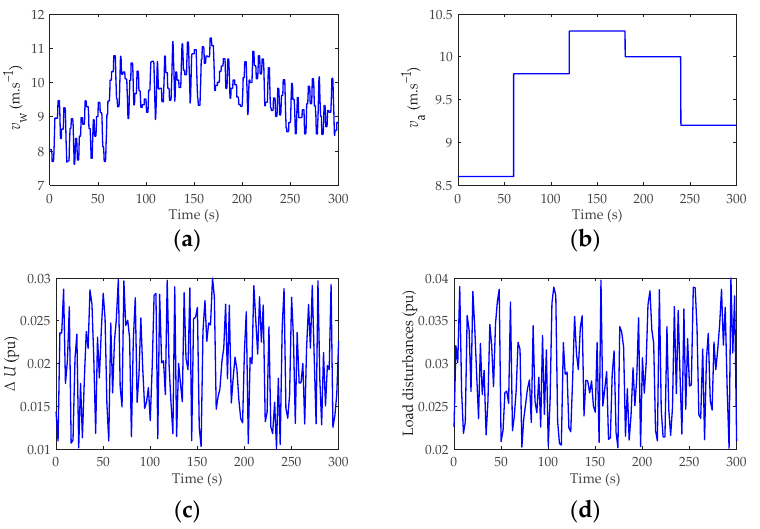
Figure 9. External disturbances and system uncertainties ( a ) Wind speed v w . ( b ) Average wind speed per minute v a . ( c ) System uncertainties of the BESS ∆ U . ( d ) Load disturbances ∆ P d 1 and ∆ P d 2 .